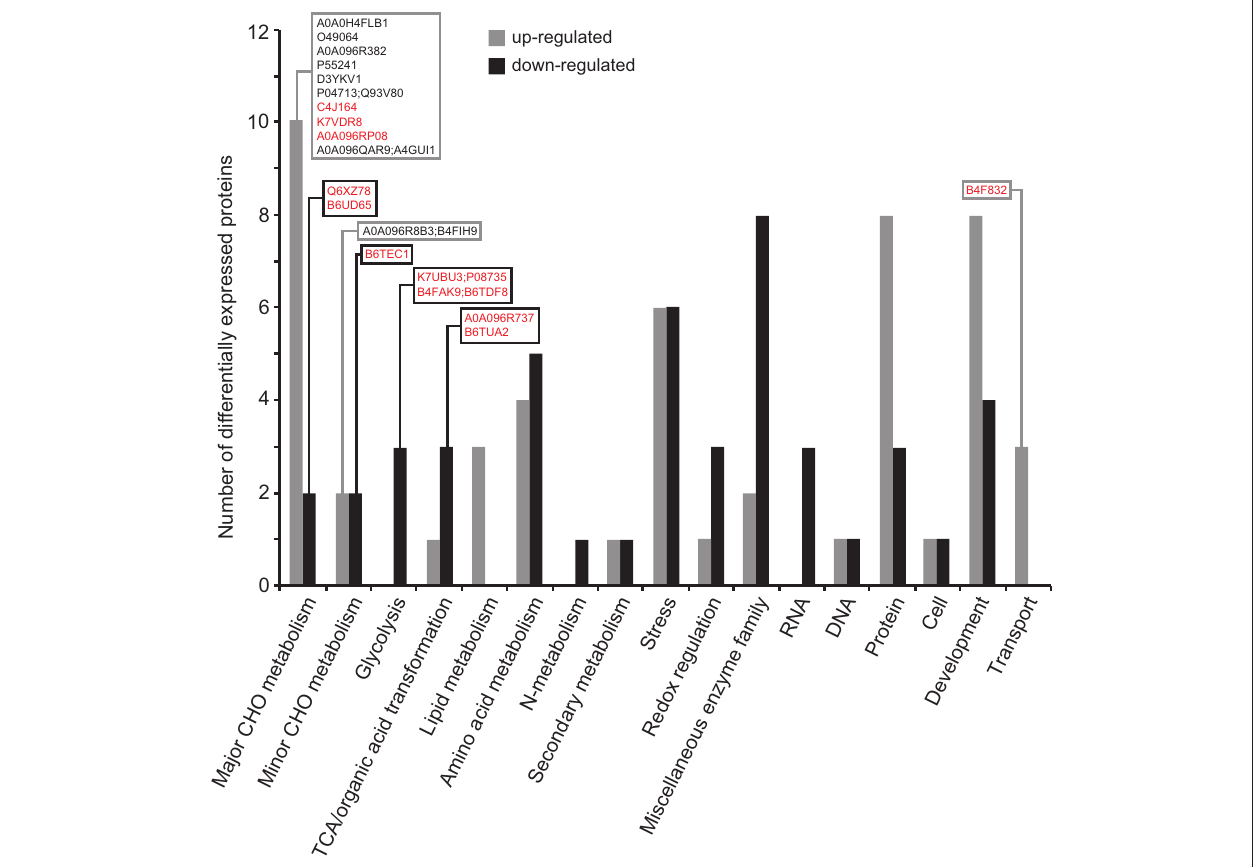
FIGURE 5 | Functional categorization of the proteins differentially expressed in endosperms of Zmbt1-1::MitTPr- 1 TP-ZmBT1-1 and Zmbt1-1 seeds. The number of proteins that are up- and down-regulated in Zmbt1-1::MitTPr- 1 TP-ZmBT1-1 endosperms is indicated by gray and black bars, respectively. Proteins are indicated by their accession numbers. Their descriptions are shown in Supplemental Table 3 . Proteins discussed here are boxed. Proteins that are differentially expressed in WT and Zmbt1-1 seeds are highlighted in